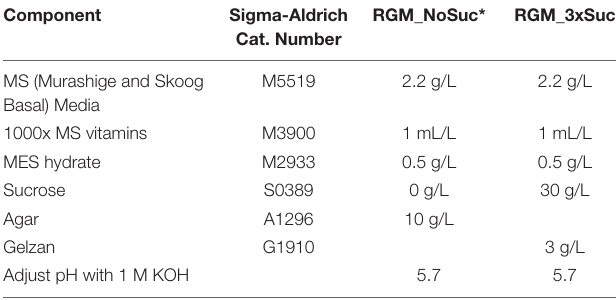
TABLE 1 | Media formulation.